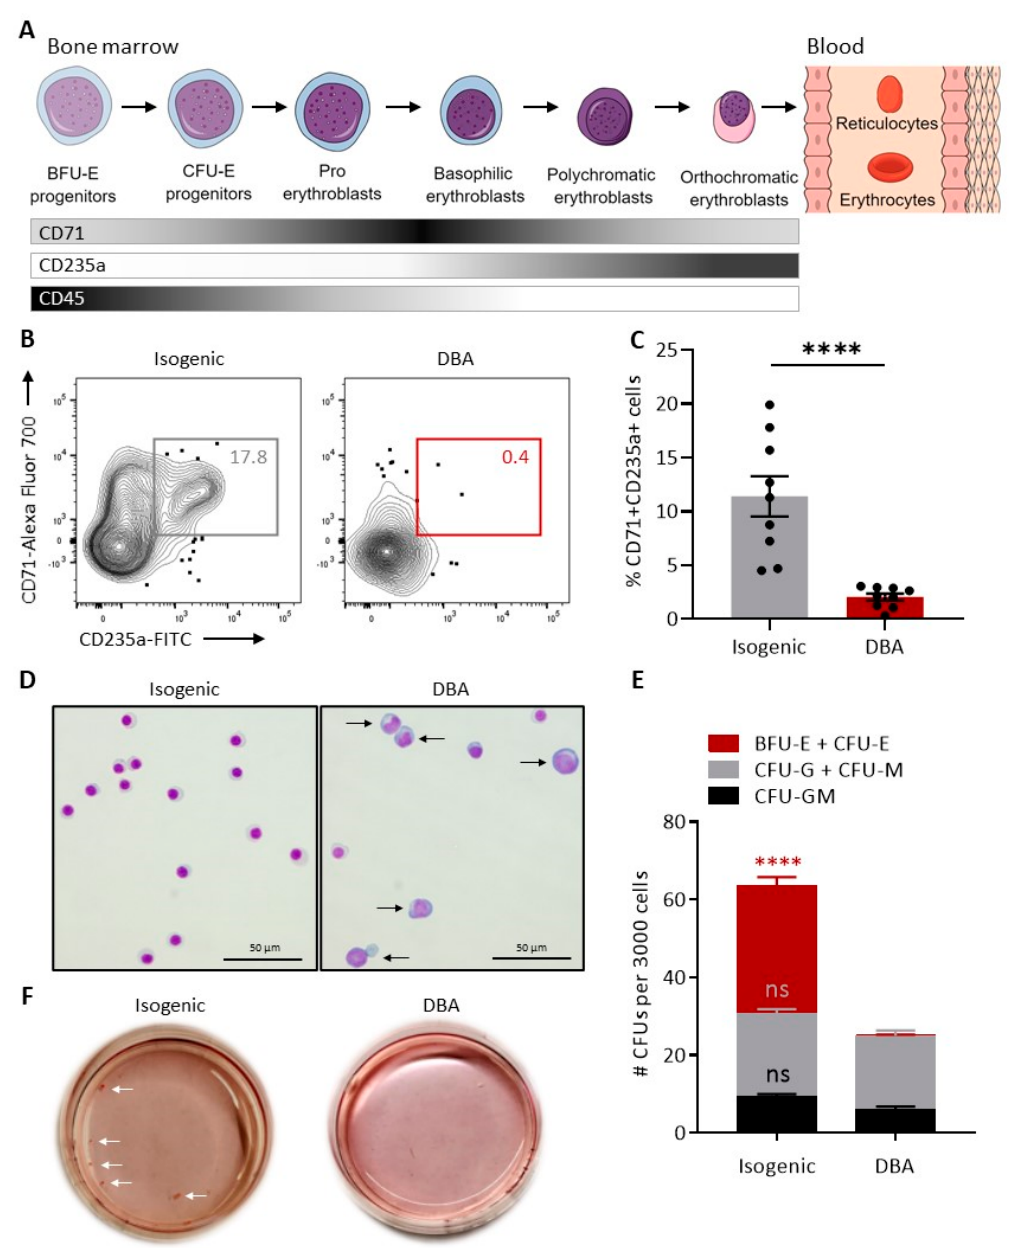
Figure 2. Hematopoietic differentiation of DBA iPSCs phenocopies in vitro the erythroid maturation defect found in DBA. ( A ) Stages of erythroid maturation defined by cell populations expressing variable levels of CD71 (transferrin receptor), CD235a (glycophorin A) and CD45. ( B ) Representative flow cytometry contour plots depicting percentages of late-stage CD45 − erythroblasts co-expressing CD71 and CD235a at culture day 21 of isogenic and DBA iPSC differentiation. ( C ) Percentages of CD71 + CD235a + late-stage CD45 − erythroblasts at culture day 19 or 21 of isogenic and DBA iPSC differentiation ( n = 9). ( D ) Representative Giemsa stains of hematopoietic cells at culture day 21 of isogenic and DBA iPSC differentiation. ( E ) Number of colony forming units (CFUs) per 3000 hematopoietic cells harvested at culture day 19 or 21 of isogenic and DBA iPSC differentiation ( n = 16). ( F ) Representative CFU plates for hematopoietic cells harvested at culture day 21 of isogenic and DBA iPSC differentiation. White arrows point to erythroid colonies. In panels C and E, data are presented as mean ± SEM. In panel E, statistical analysis is presented for each colony type relative to the “DBA iPSCs” group. Unpaired t -test, **** p ≤ 0.0001, ns: not